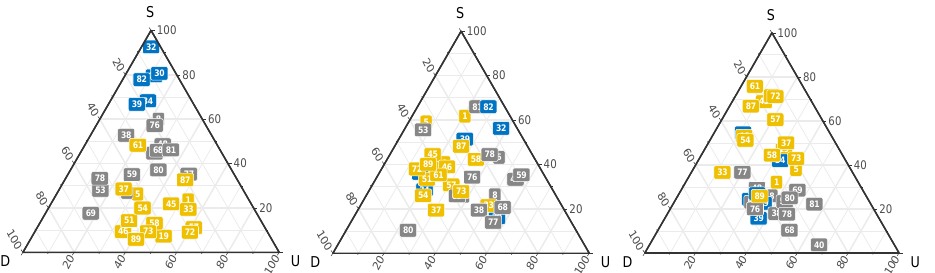
Figure 3. The ternary figure describes participants’ proportion of different strategies in the non outcome-based group. Each color represents a cluster group based on players’ action proximity. S, stay; D, downgrade; U upgrade.